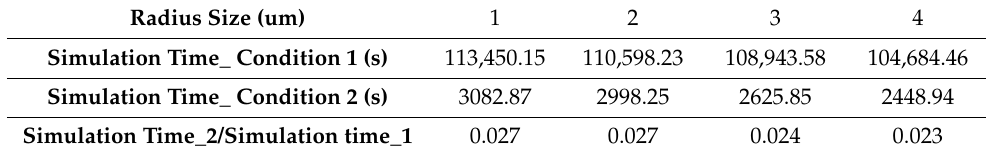
Table 9. Simulation extinction coefficient under different concentrations.